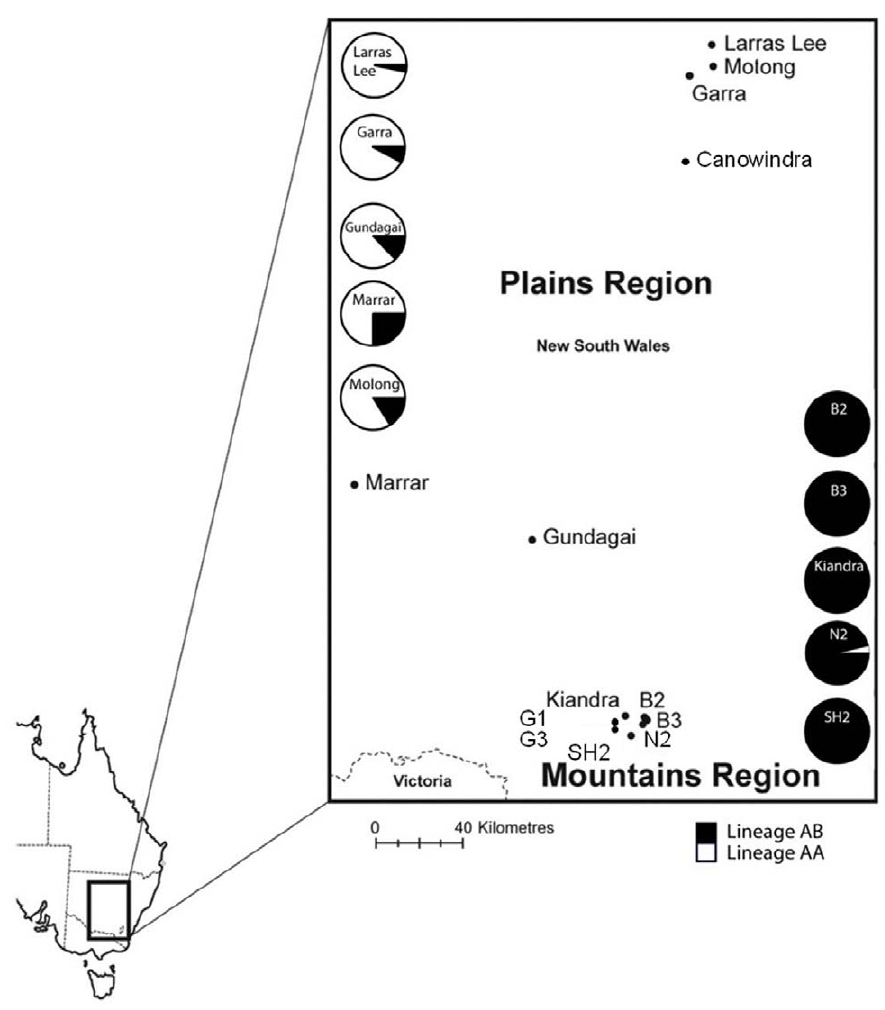
Figure 1. Geographical distribution of M.lini lineages in the Mountains and Plains regions in southeastern New South Wales, Australia. Within each region, 5 host-pathogen population pairs were sampled for regional assessments of host resistance and pathogen infectivity. Genetic characterization of pathogen isolates (collected during the 2006 growing season) was conducted using microsatellite markers. On average, 30 pathogen isolates were tested per population.